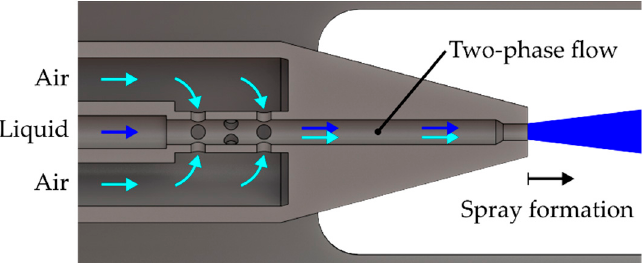
Figure 2. Schematic diagram of the air ‐ assisted atomizer with an inner mixing chamber.